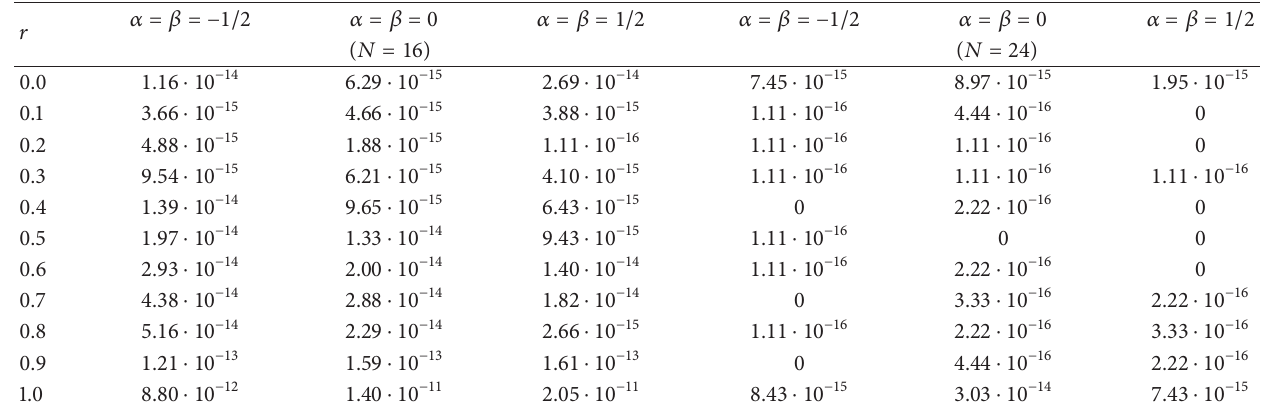
Table 3: Absolute residual error functions for 𝑛 = 5, 𝜆 = 1/2